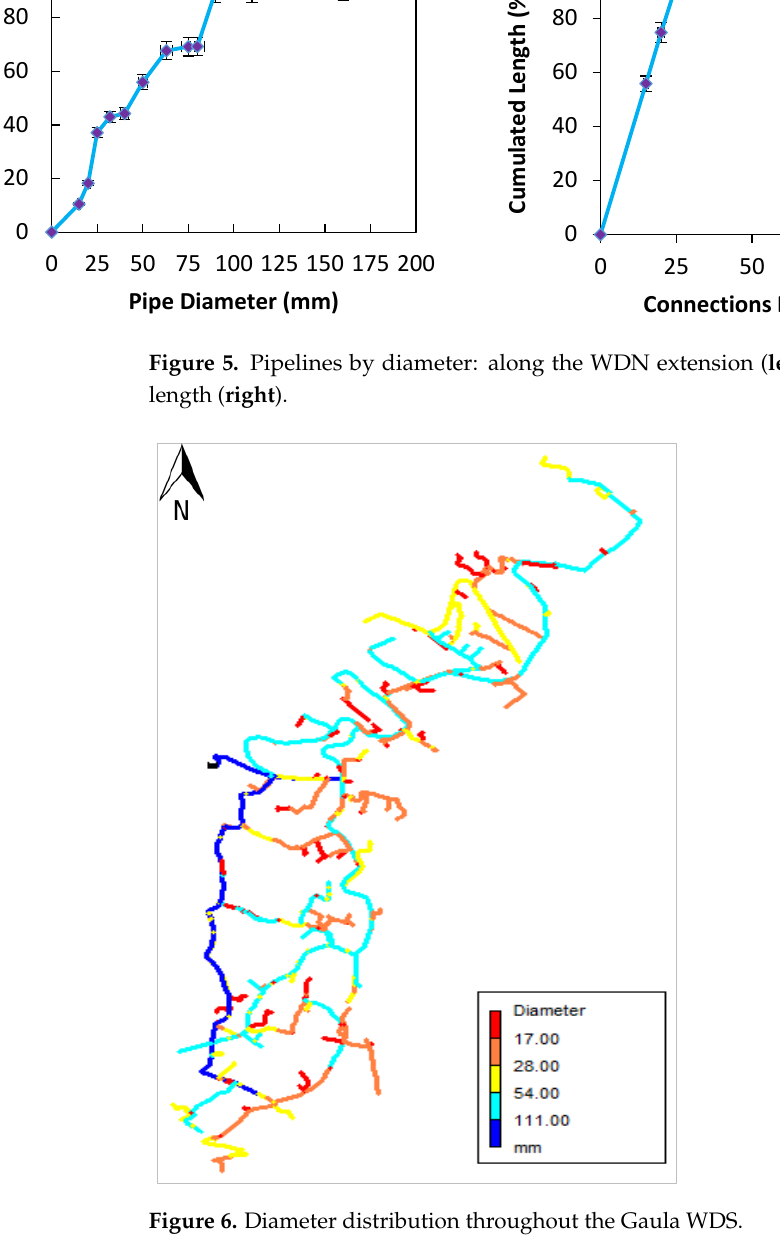
Table 1. Reported reference for Gaula water volumes (in 2019) .